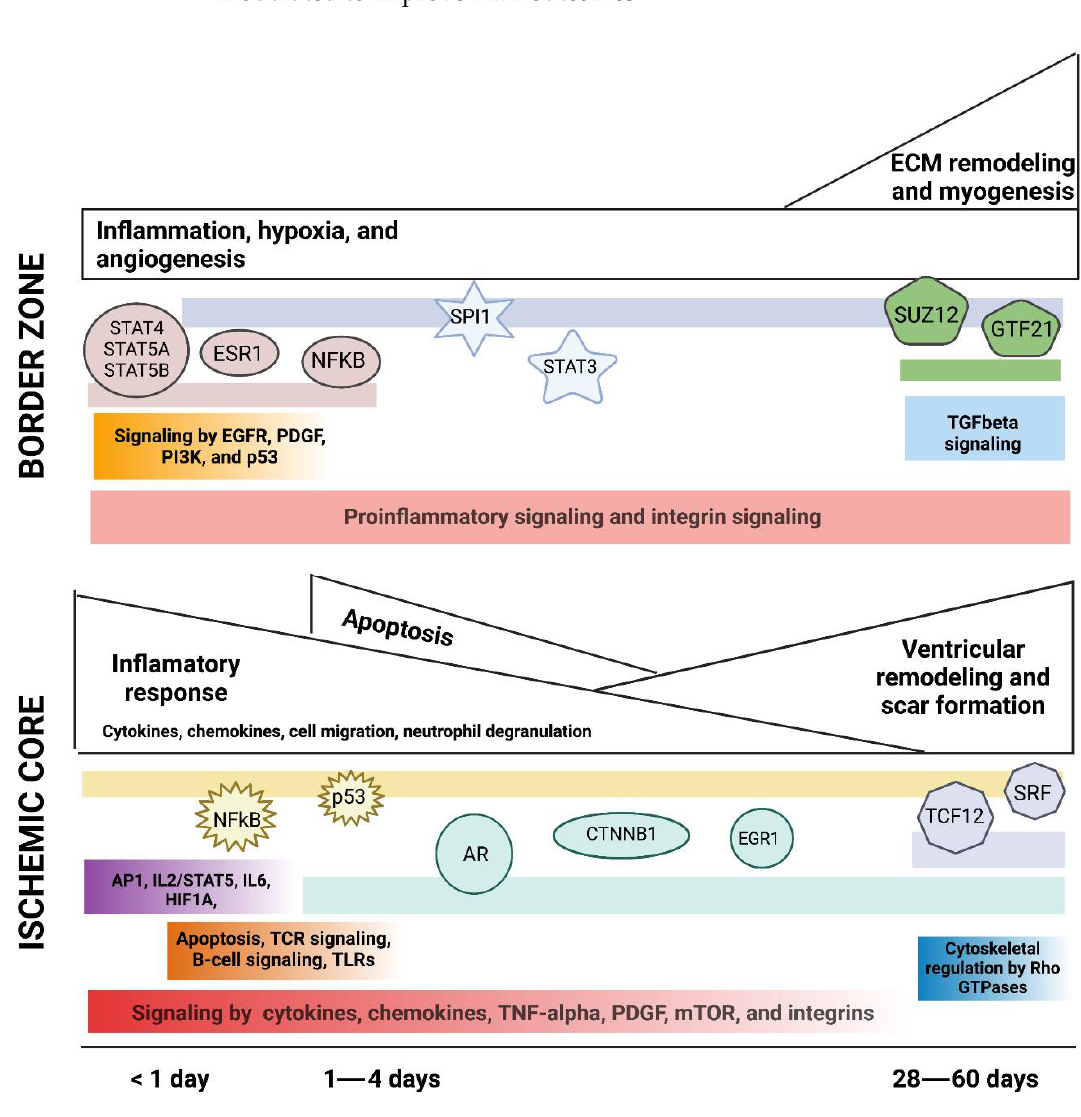
Figure 6. Spatiotemporal pathways transcriptionally modulated after myocardial IRI in swine. Transcriptomic analysis of cardioprotective interventions early post-infarction (Table 3) revealed the upregulation of MAPK cascades, the mitochondrial energy metabolism, and neddylation (Figure 7). Various studies have established a link between MAPK signaling and mitochondria [72]. Mitochondrial KATP channels protect against myocardial IRI, and cardioprotective strategies that activate PKC also potentiate mitochondrial KATP